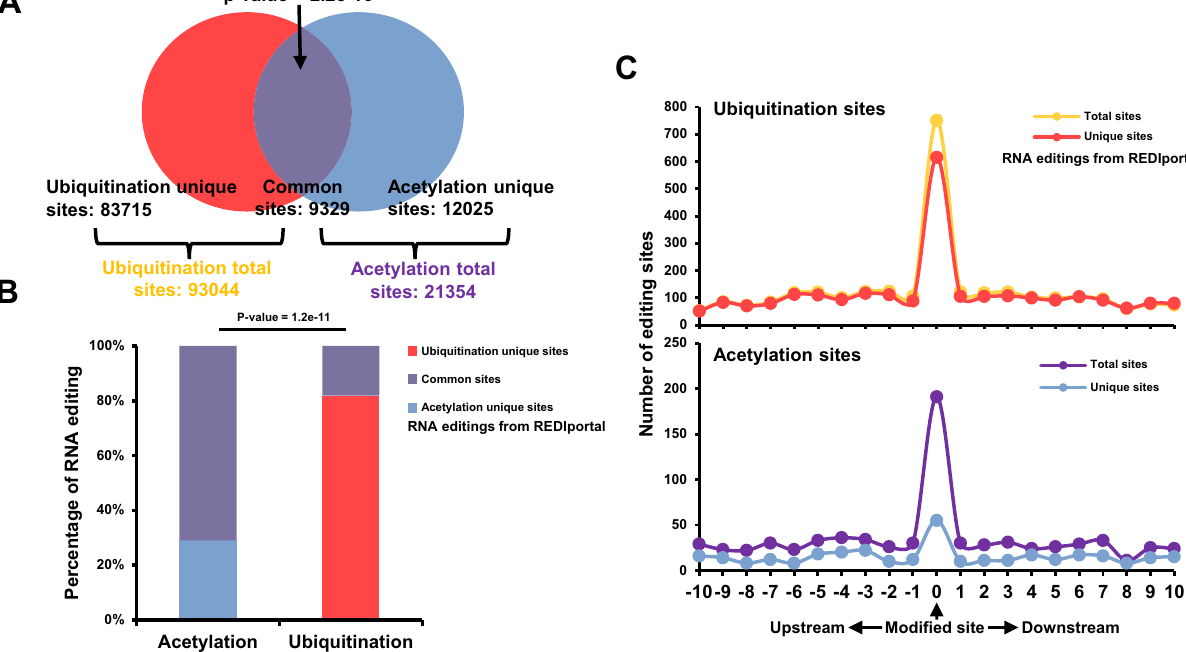
Figure 2. Overlaps between nonsynonymous RNA editings and ubiquitination sites. ( A ) Venn plotting showed the overlaps between ubiquitination and acetylation sites in PhosphoSitePlus database. ( B ) Bar plot demonstrating the percentage of nonsynonymous RNA editing in REDIportal database located in the ubiquitination unique and acetylation unique sites. The P-value was computed by one-sided “fisher.test” function in R. ( C ) The distribution of nonsynonymous RNA editing from REDIportal database on total and ubiquitination unique site and flanking regions (upper) and on total and acetylation unique site and flanking regions